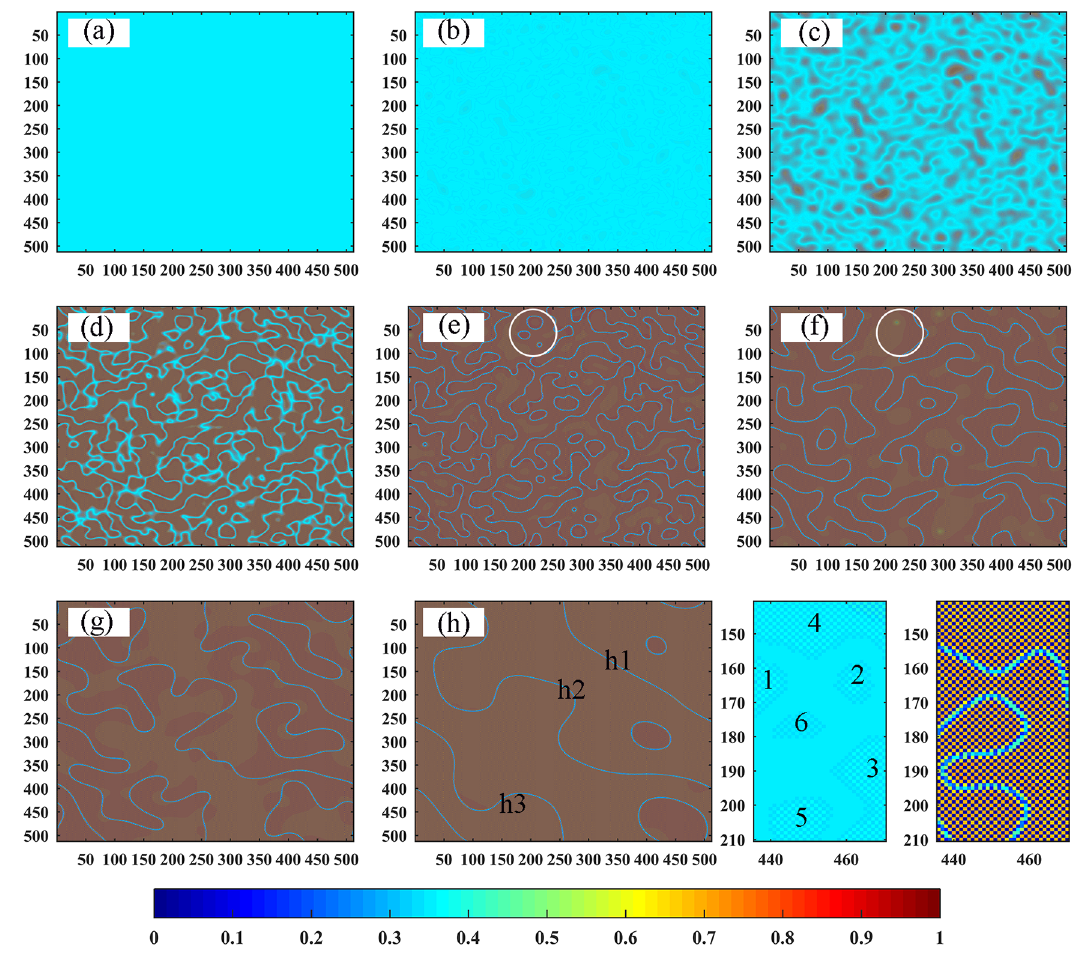
Figure 2. The morphological evolution of B2-FeAl ordered domains in Fe-35at. % Al, T = 973 K. (a)-(h) represent the instantaneous photographs corresponding to t = 50, 950, 1000, 1050, 2200, 8950, 25050, 100000. The lowest bar is the color schematic diagram for atomic distribution function values at different